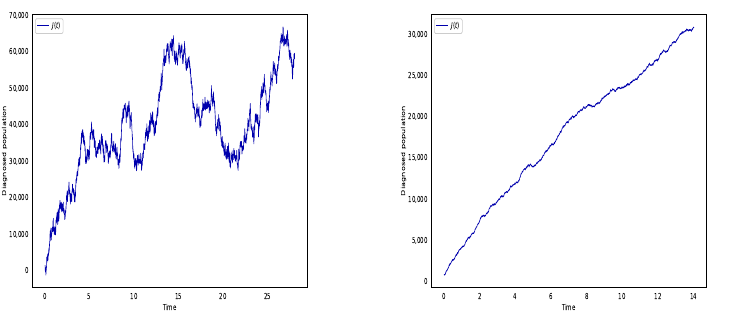
Figure 2. The numbers of diagnosed patient between 23 January and 20 February ( left ), and between 20 February and 6 March ( right ).